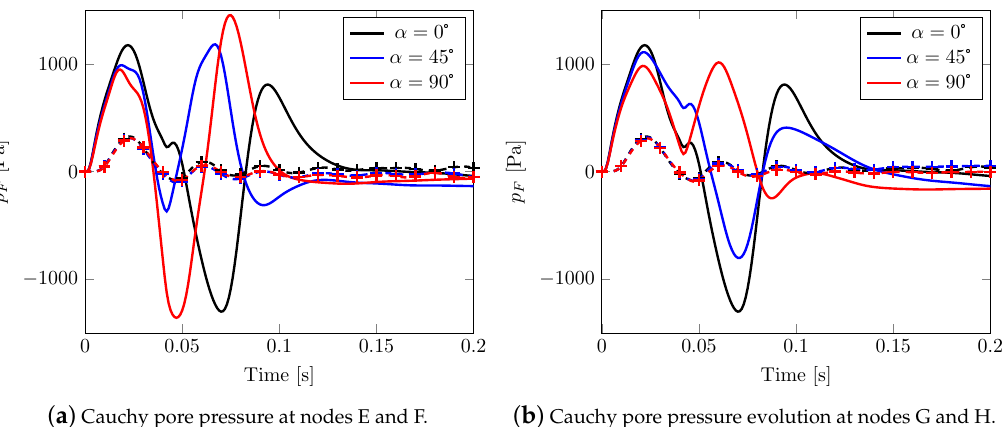
Figure 13. Cauchy pore pressure evolution in time: solid line for nodes E and G, marked line for nodes F and H.